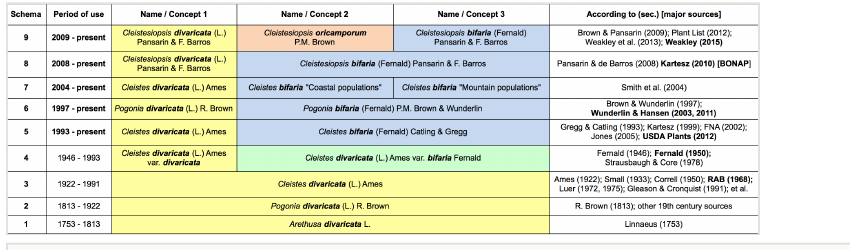
Figure 1. Taxonomic concept labels and concept-to-concept articulations, represented in a tabular alignment of nine schemata, for the Cleistes use case (sec. A.S. Weakley). The vertical column position and width of taxonomic concept labels indicates taxonomic non-/congruence. The colors approximate taxonomic name lineages, e.g. blue for bifaria and yellow for